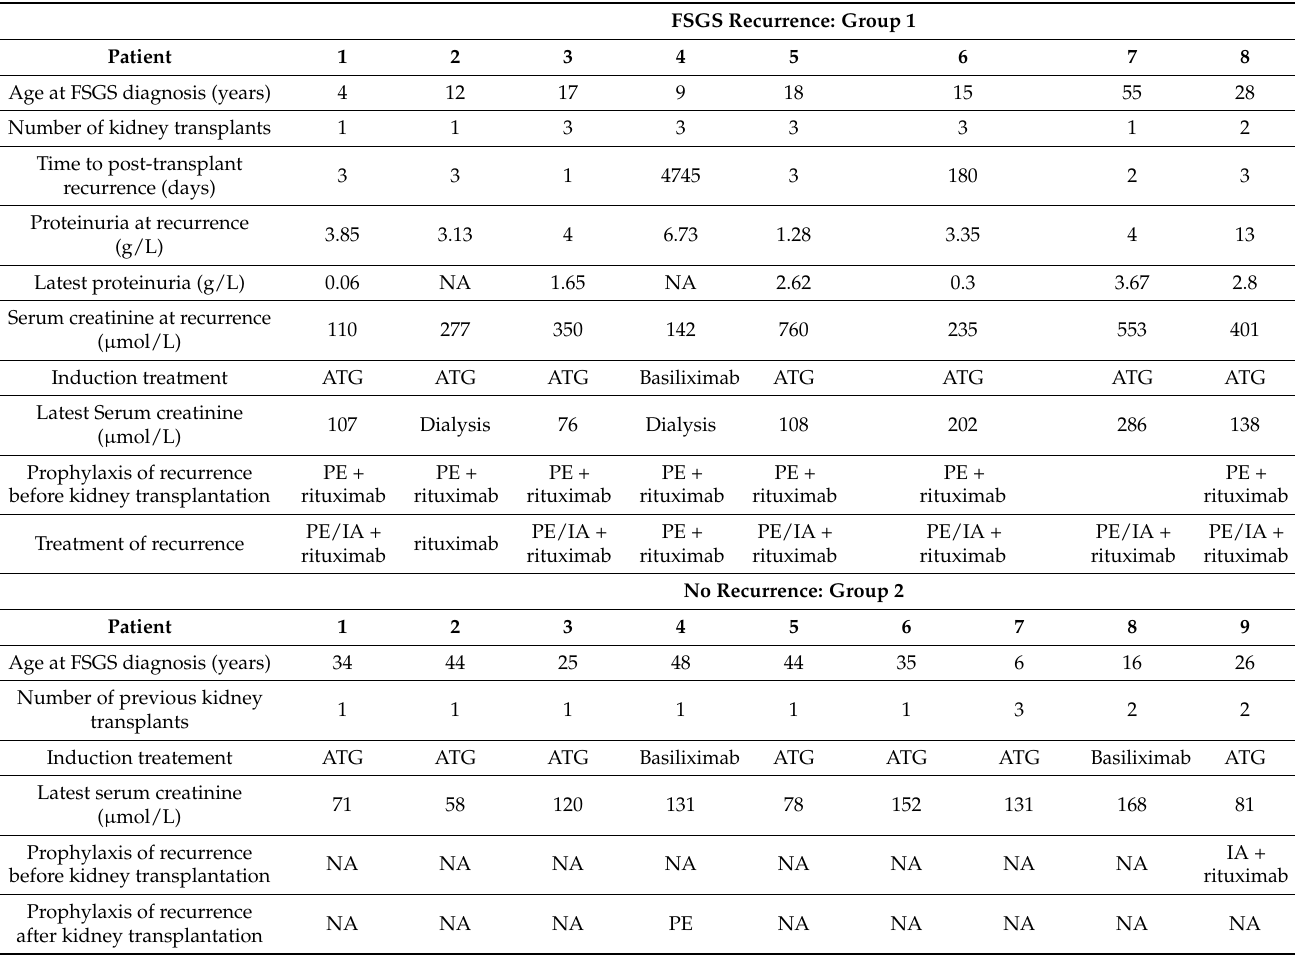
Table 2. Characteristics of patients.